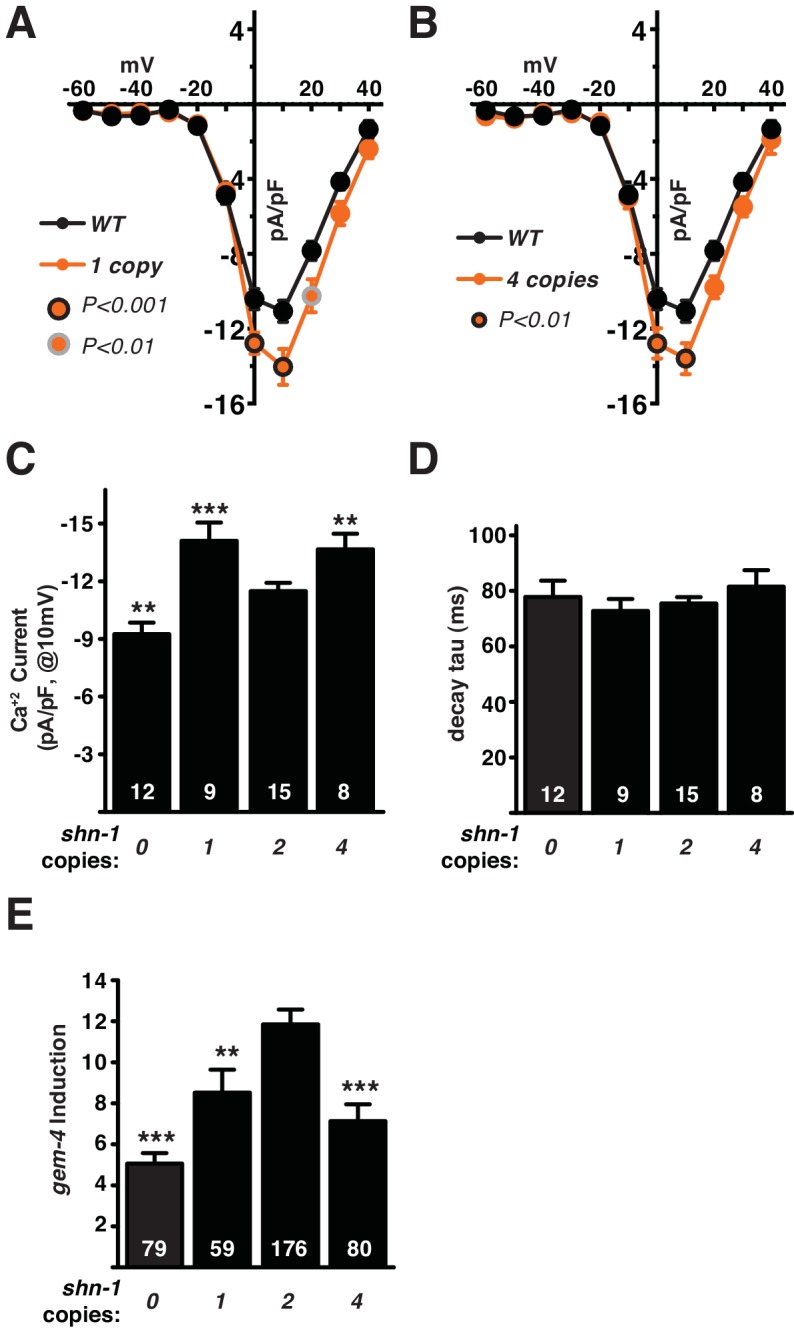
shn-1 gene dosage regulates calcium current density and gem-4 induction.The effect of varying shn-1 gene dosage on calcium current density (A–B) and gem-4 induction (C) was analyzed. The following genotypes were analyzed: 0 copies of shn-1 [shn-1(tm488) homozygotes], 1 copy of shn-1 [shn-1(tm488)/+ heterozygotes], 2 copies of shn-1 (wild-type) and 4 copies of shn-1 (nuSi26 homozygotes in wild-type). (A–B) Muscle Ca+2 current was sensitive to changes in shn-1 gene dose, with decreased (0 shn-1 copies) and increased (1 and 4 shn-1 copies) current density observed in the indicated genotypes. Mean current density as a function of holding potential (A), mean current density at 10 mV (B), and mean current deactivation time constants (C) are shown. (D) Lev-induced gem-4 expression was significantly reduced in animals with 0, 1, and 4 copies of shn-1. The number of animals analyzed is indicated for each genotype. Values that differ significantly from wild type controls are indicated (***p<0.001; **p<0.01). Error bars indicate SEM. Mean, standard errors, sample sizes, and p values for panels A-C are shown in Supplementary file 1.